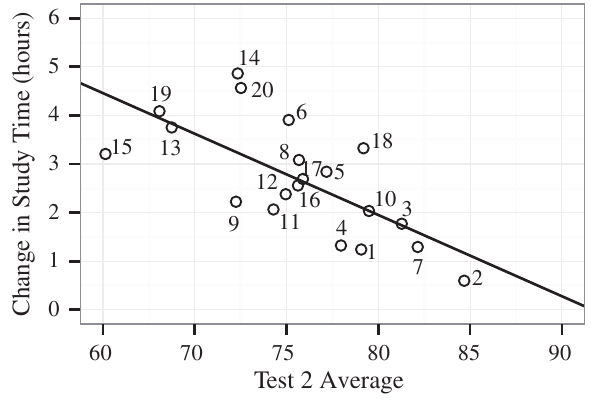
FIG. 2. Change in exam study time vs test 2 average by semester.